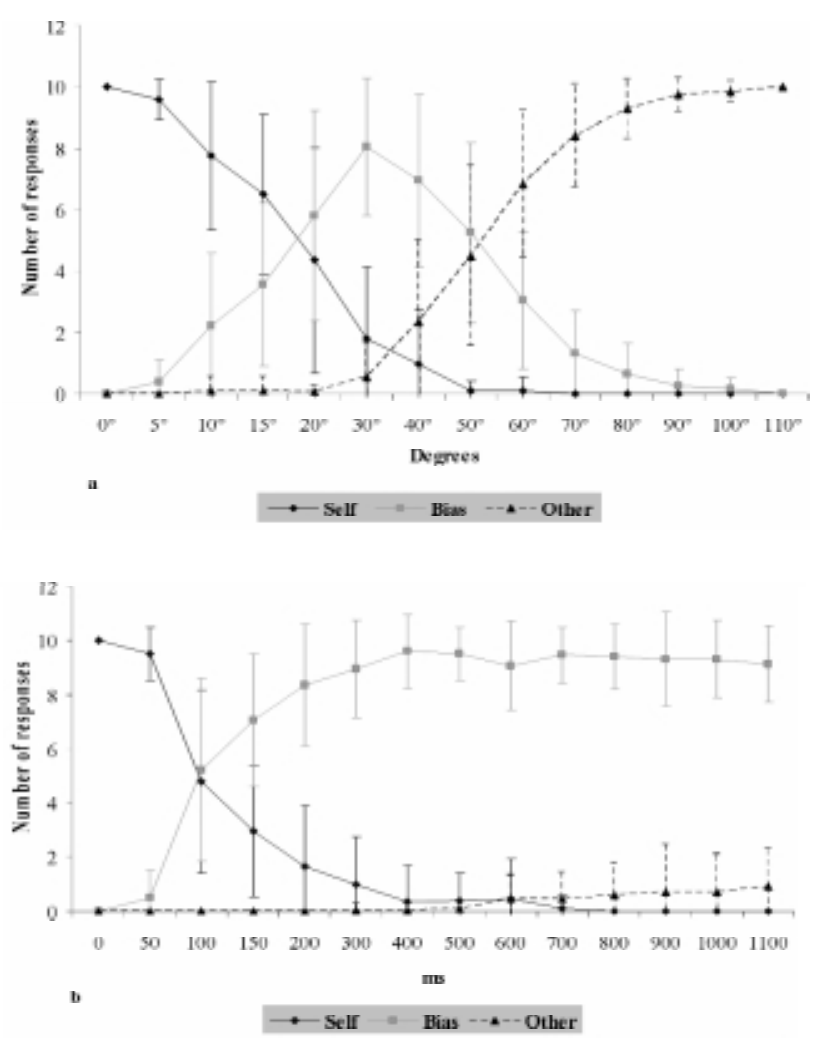
Fig. 2. (a) Means and standard deviations of the number of “self” responses, “bias” responses and “other” responses as a function of the angular bias. (b) Means and standard deviations of the number of “self” responses, “bias” responses and “other” responses as a function of the temporal